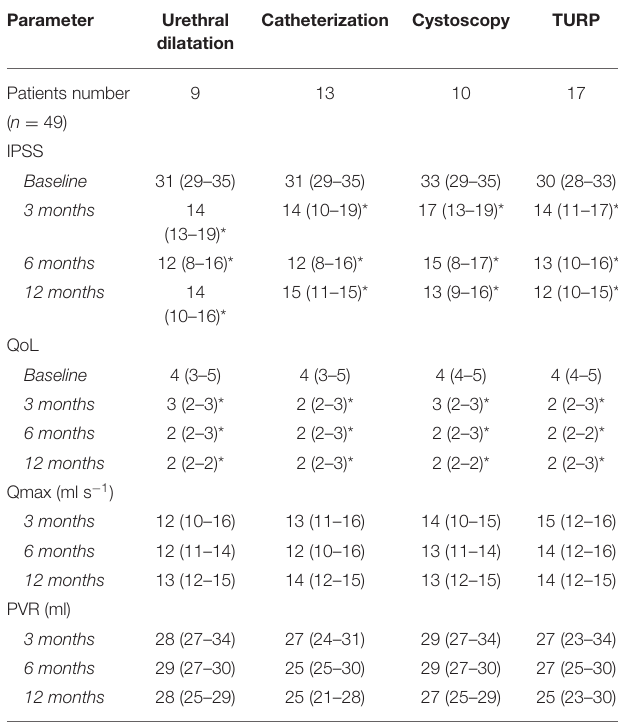
TABLE 2 | Follow-up data stratified by the causes of BMH (median, minima to maxima).